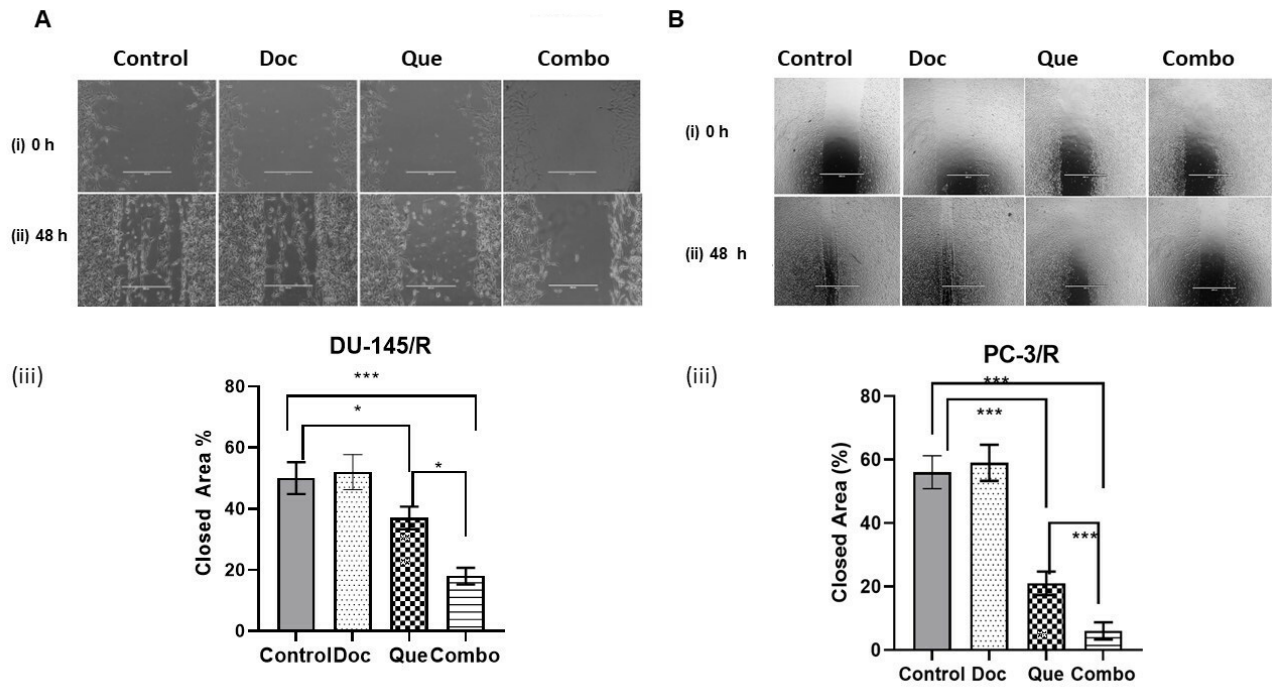
Figure 4. Effects of docetaxel and docetaxel + quercetin on migration of resistant prostate cancer cell lines DU-145/R and PC-/R. The cells were treated as described in Section 2 with either the drugs individually or in combination and were evaluated with respect to their effects on the migration after 48 h. ( A ) DU-145/R cells and ( B ) PC-3/R cells. We performed three experiments in triplicate and the data are presented as means ± S.D. * p < 0.05, *** p < 0.001. In both ( A ) and ( B ), (i) is a cell image at 0 h, (ii) is a cell image at 48 h, and (iii) shows a graphic representation of the Image J software quantification of % closed area compared with the control.